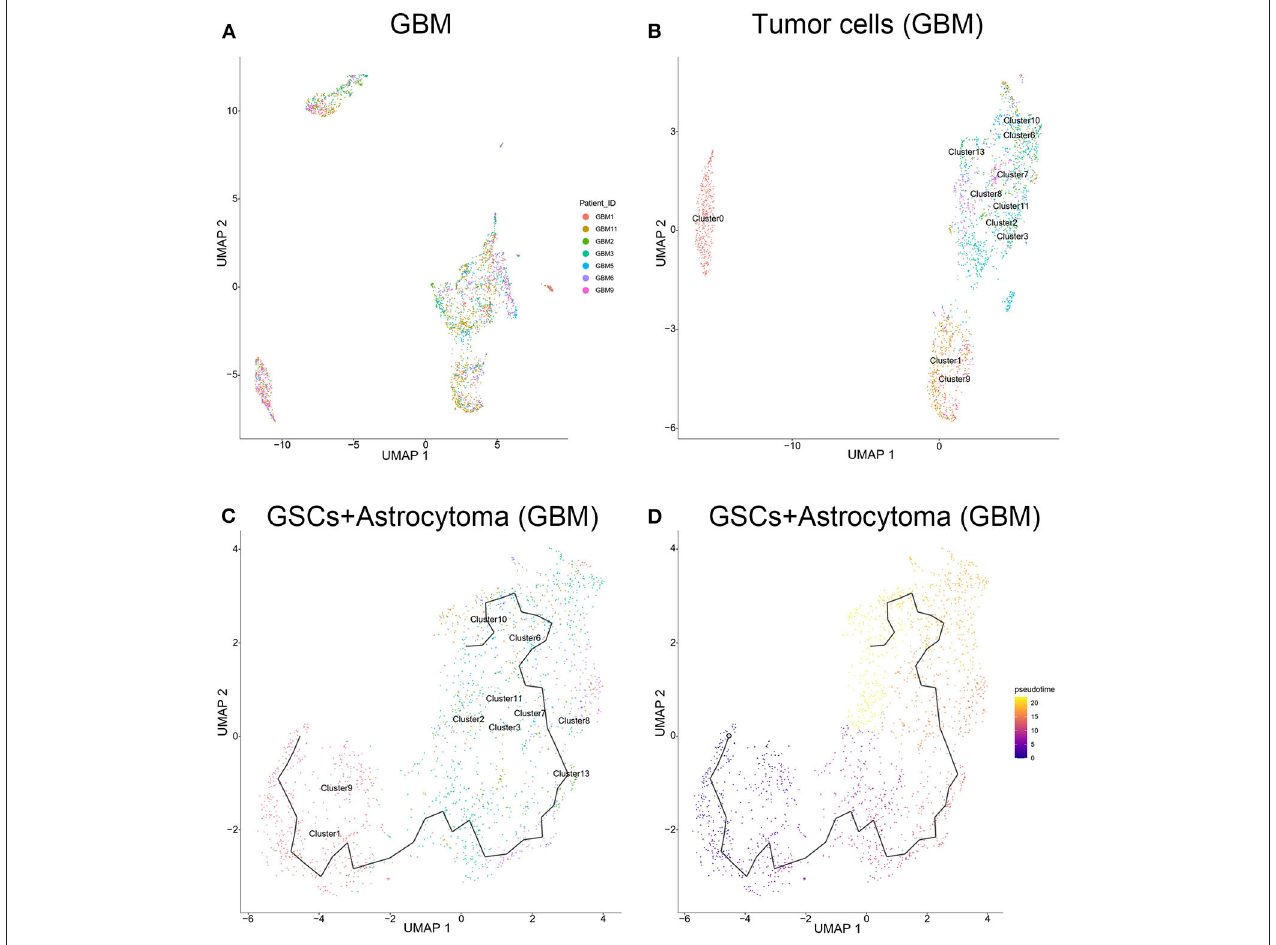
FIGURE 4 | Evolution routine of tumor cells in surgical specimens. (A) No significant batch difference in tumor cells from different surgical specimens. (B) Tumor cell subgrouping in surgical specimens. (C) The evolution direction of tumor cells in surgical specimens. (D) The pseudo-time sequence of evolution of tumor cells in surgical